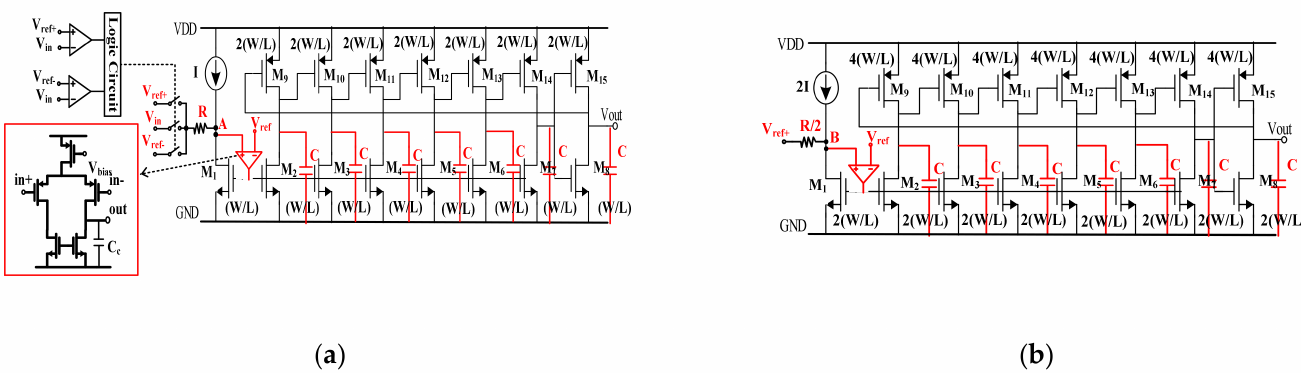
Figure 12. ( a ) Schematic of the proposed VCO; ( b ) schematic of the oscillator as the clock